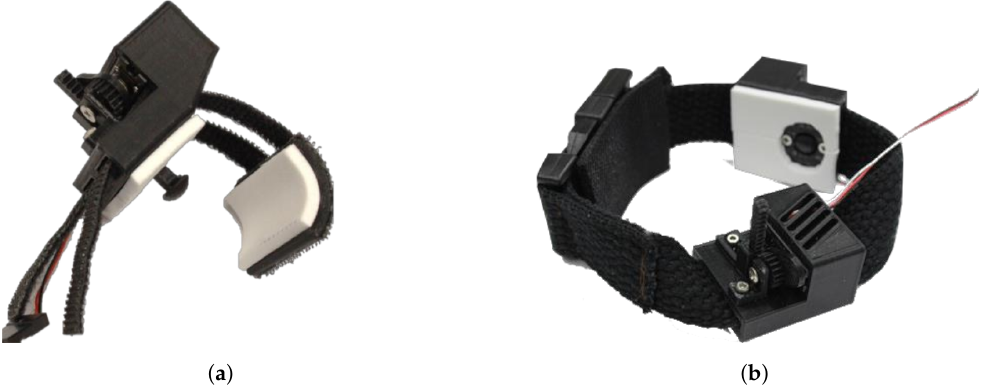
Figure 4. ( a ) Mechanotactile tactors on forearm mounting system. ( b ) Mechanotactile tactors on fingertip mounting system.